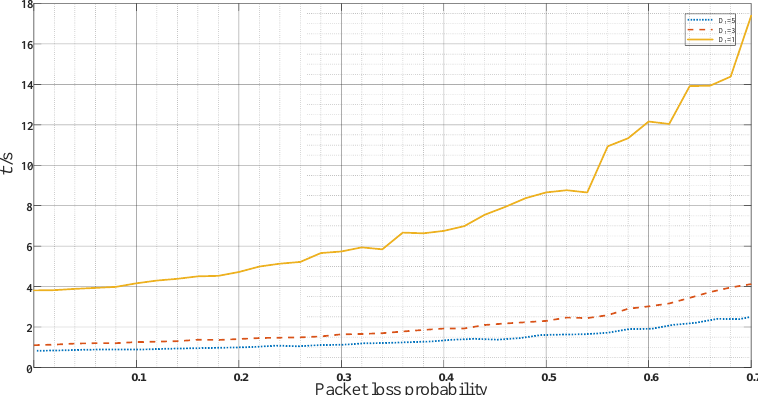
Figure 10. System convergence time with different leader connectivity links.